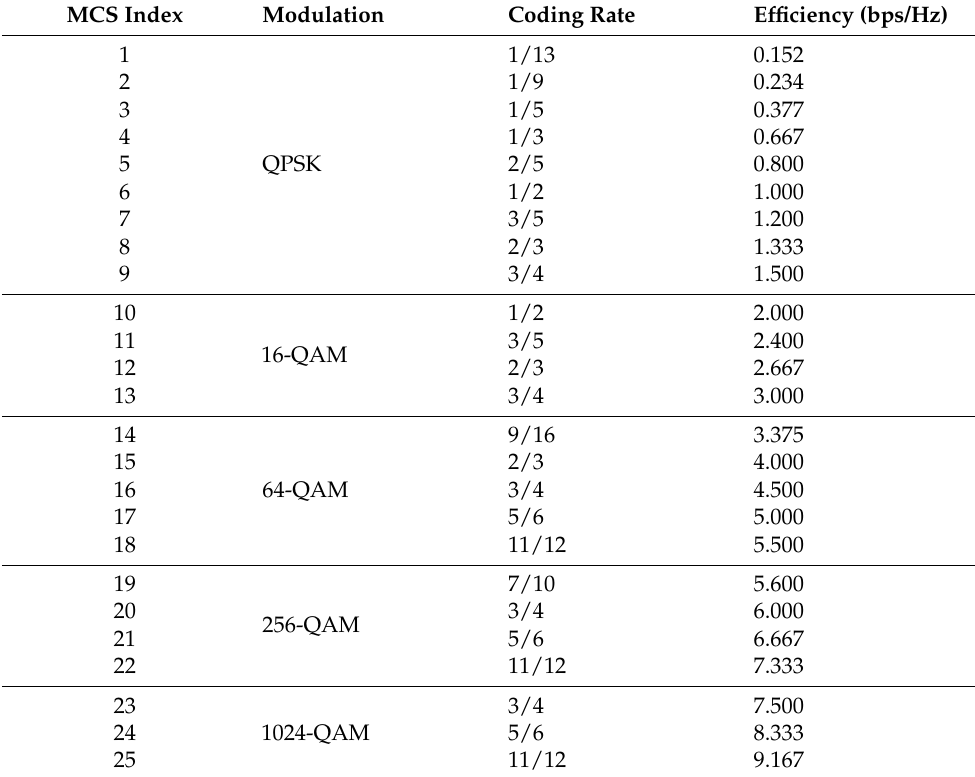
Table 2. 25 MCS indexes incorporating